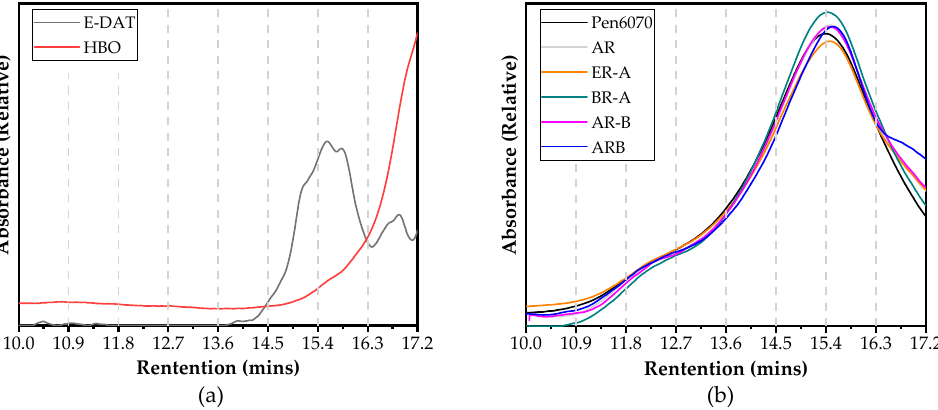
Figure 8. GPC test results: ( a ) chromatograms of Evotherm-DAT and HBO and ( b ) chromatograms of test binders.